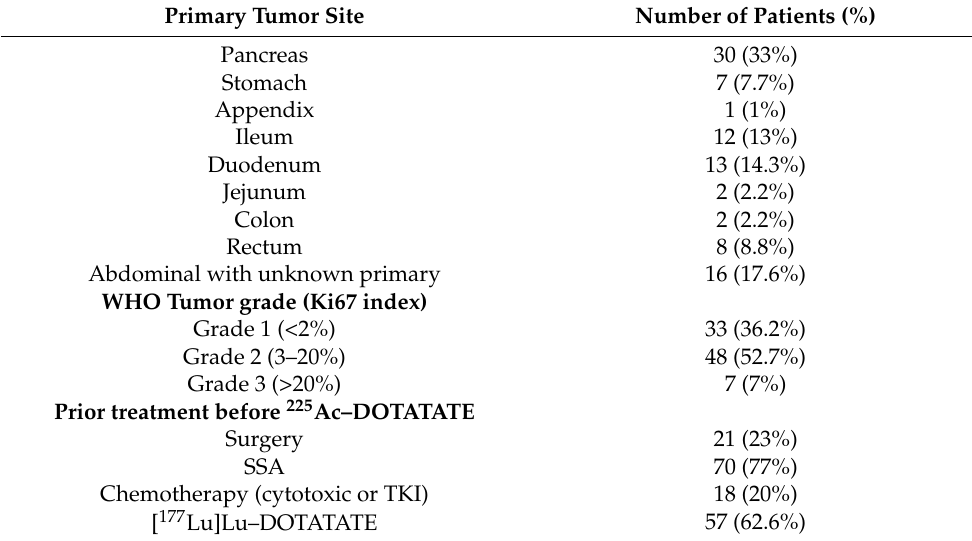
Table 4. Site of primary tumor, WHO grades and prior treatments received by the patients involved in the study of Ballal et al. [212].